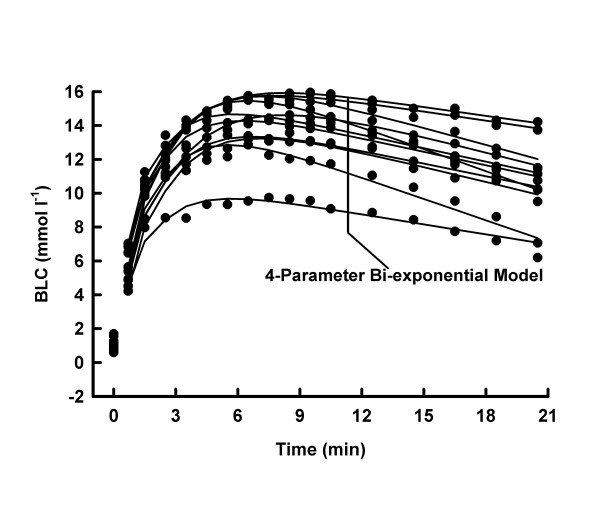
BLC, individual 4-parameter model approximations for MSE30.